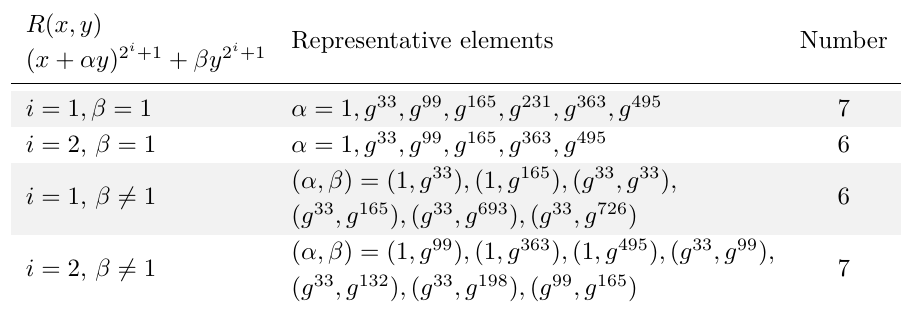
constructed with butterfly 2 5